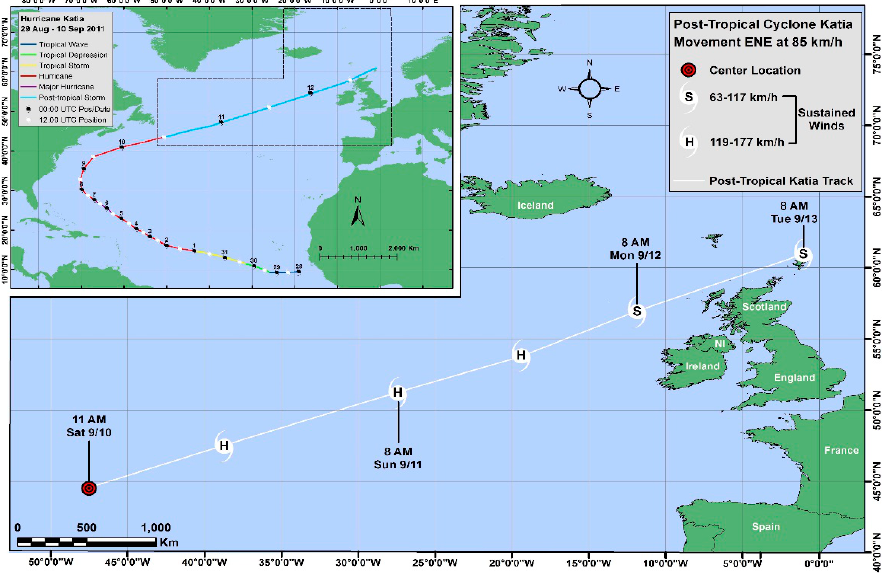
Figure 1. Track of Katia cyclone obtained from NOAA [1].